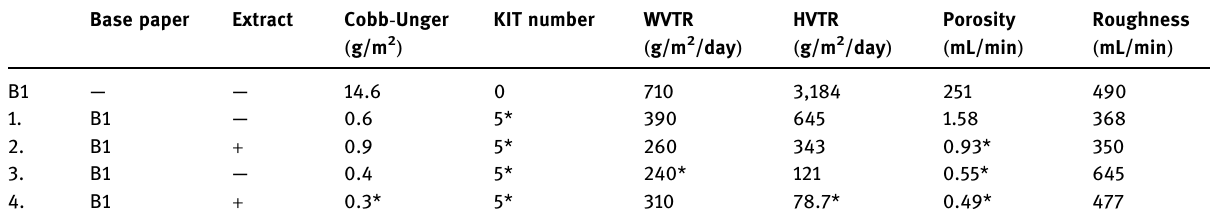
Table 2: Basic and barrier properties of papers tested with base paper 1 Base paper